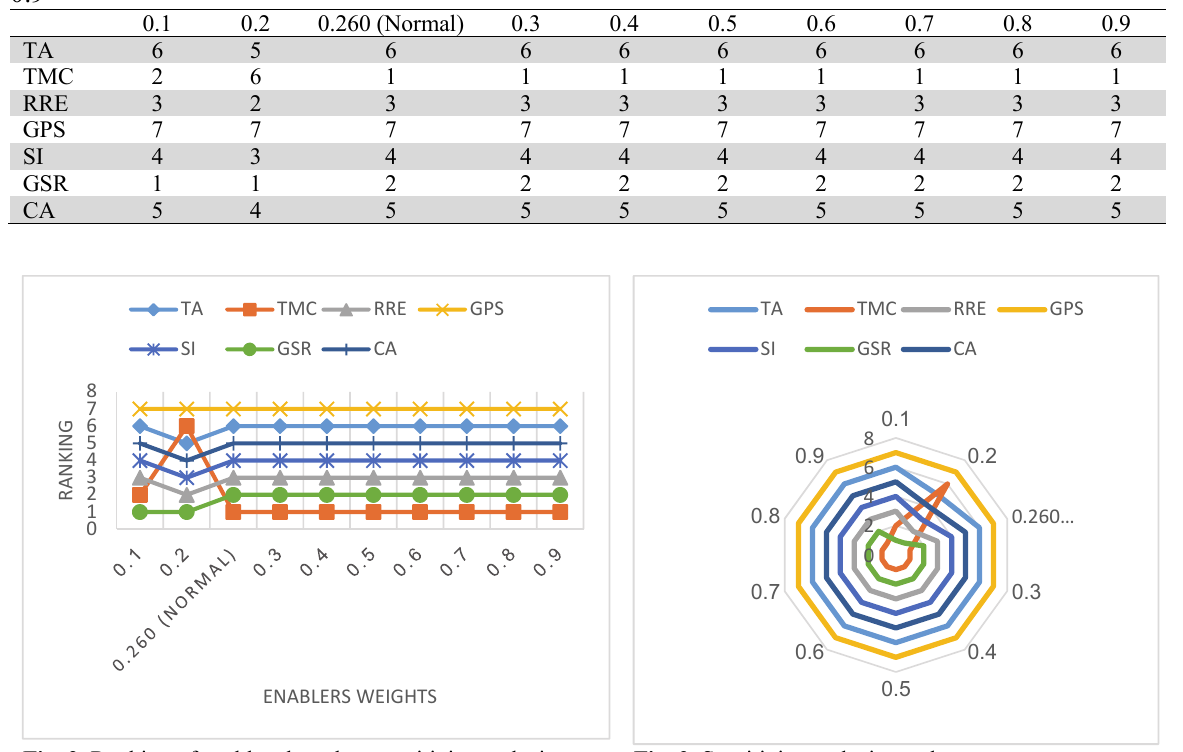
Fig. 2. Ranking of enablers based on sensitivity analysis Fig. 3. Sensitivity analysis